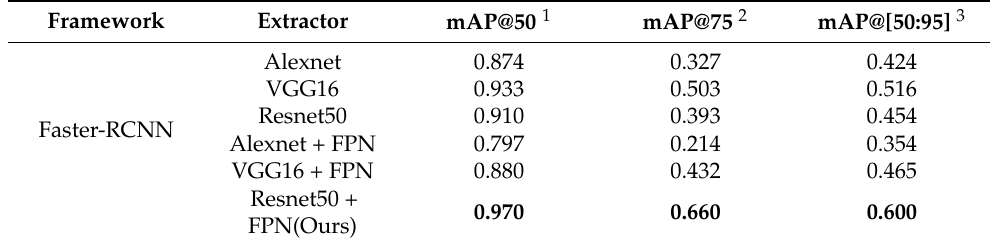
Table 2. The mean results of all target classes in the test